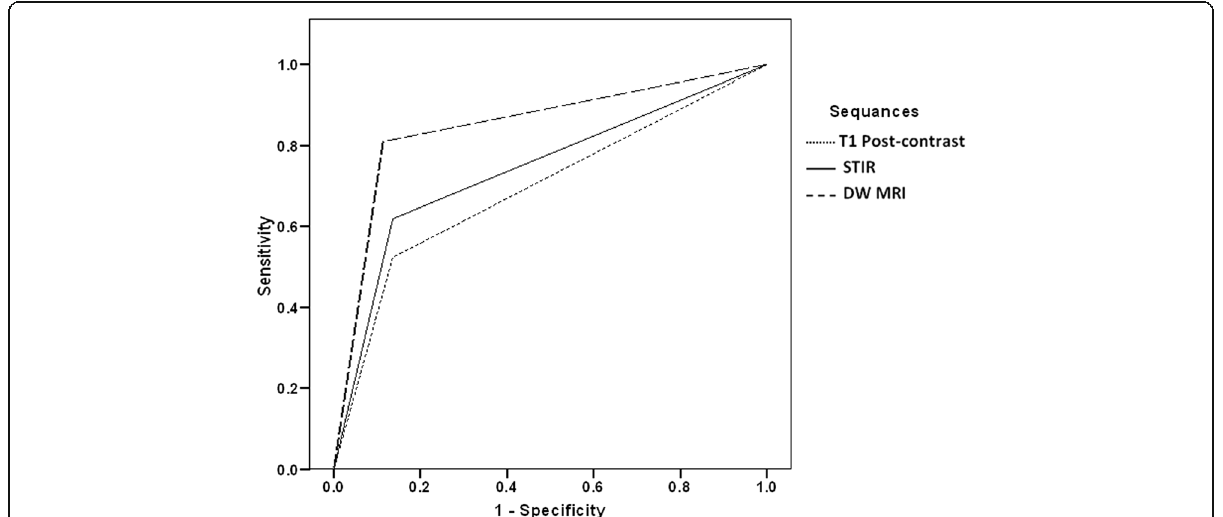
Fig. 3 ROC curve analysis of MRI sequences for identification of active inflammation of the fistula